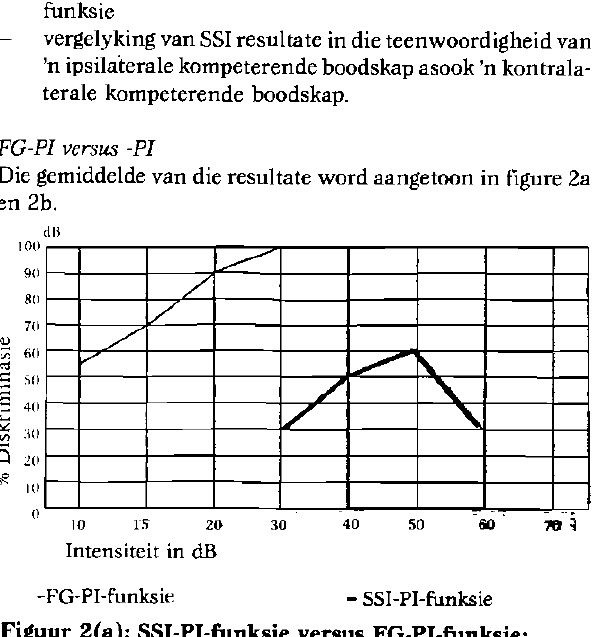
Figuur 2(a): SSI-PI-fi»nksie versus FG-PI-funksie: